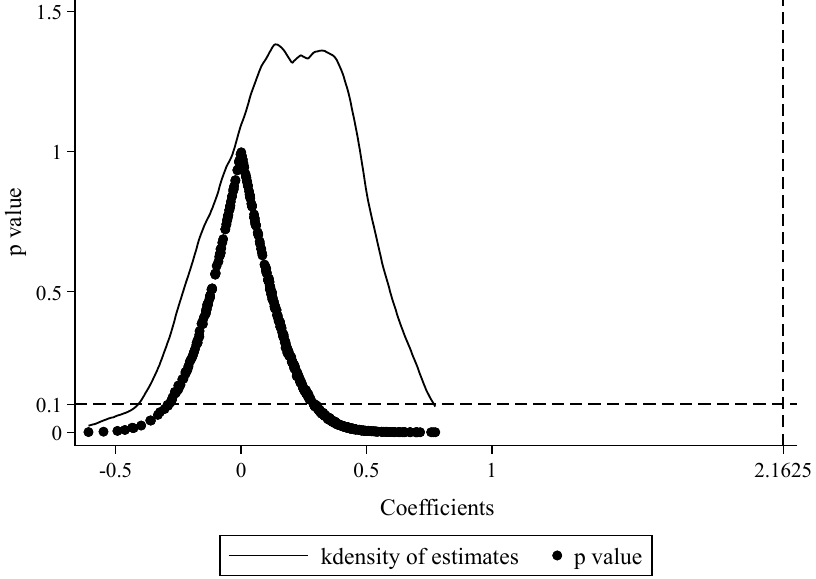
Figure 3. The placebo test of CS. Note: The X-axis is the estimated coefficients of DID for the 500 random processes. The curve is the kernel density distribution plot of the estimated coefficients, the dots are the associated p -values, and the vertical lines on the right side of the plot are the true estimated coefficients of DID, which are all significantly located in the low-tailed area of the coefficient distribution.